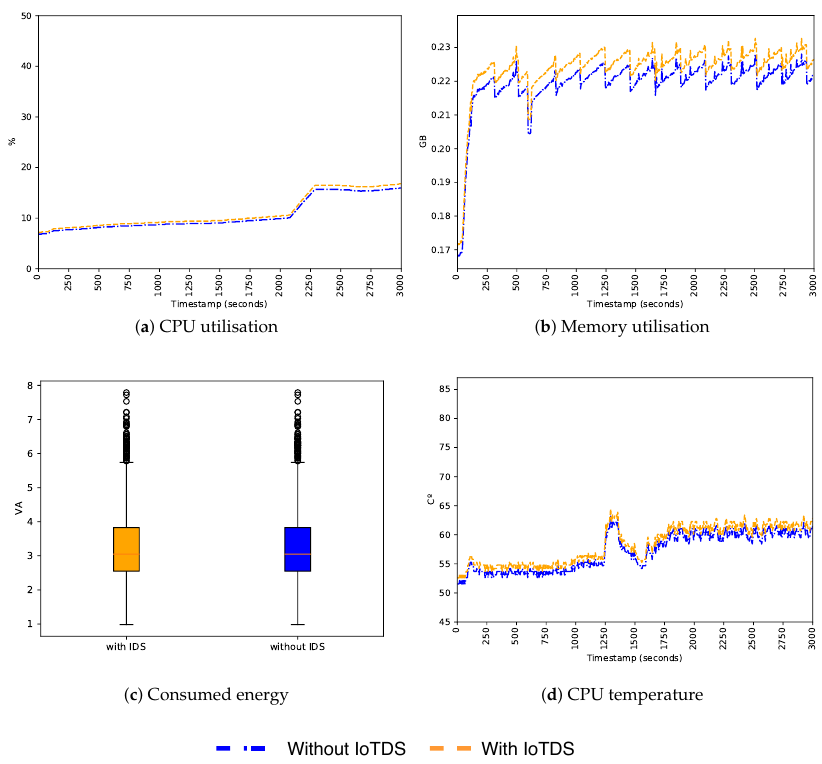
Figure 12. Behaviour of the ST profile infected with botnets regarding resource usage with and without the